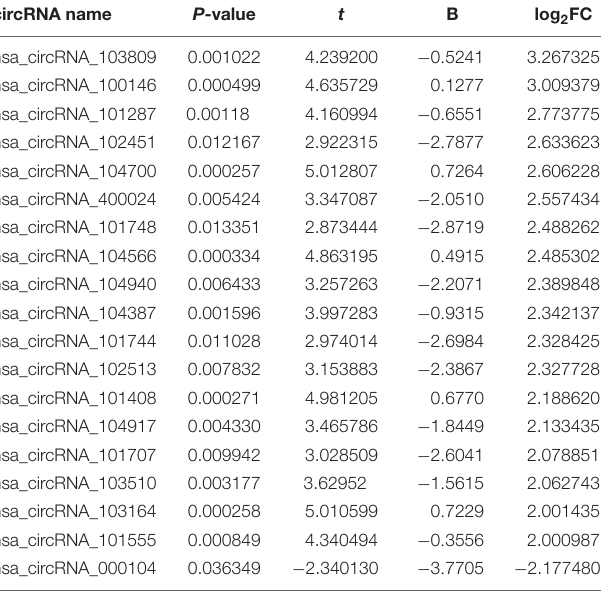
TABLE 1 | The differentially expressed circRNAs (DECs) with significance (|log 2 FC| > 2 and P < 0.05) between benign thyroid lesions and normal thyroid tissues. circRNA name